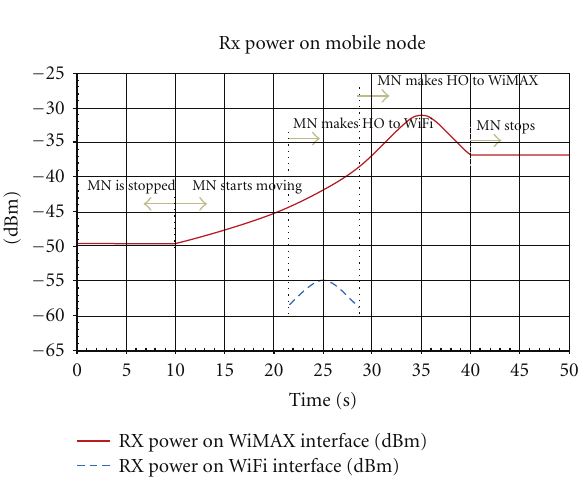
Figure 6: Received power on both MN’s interfaces.